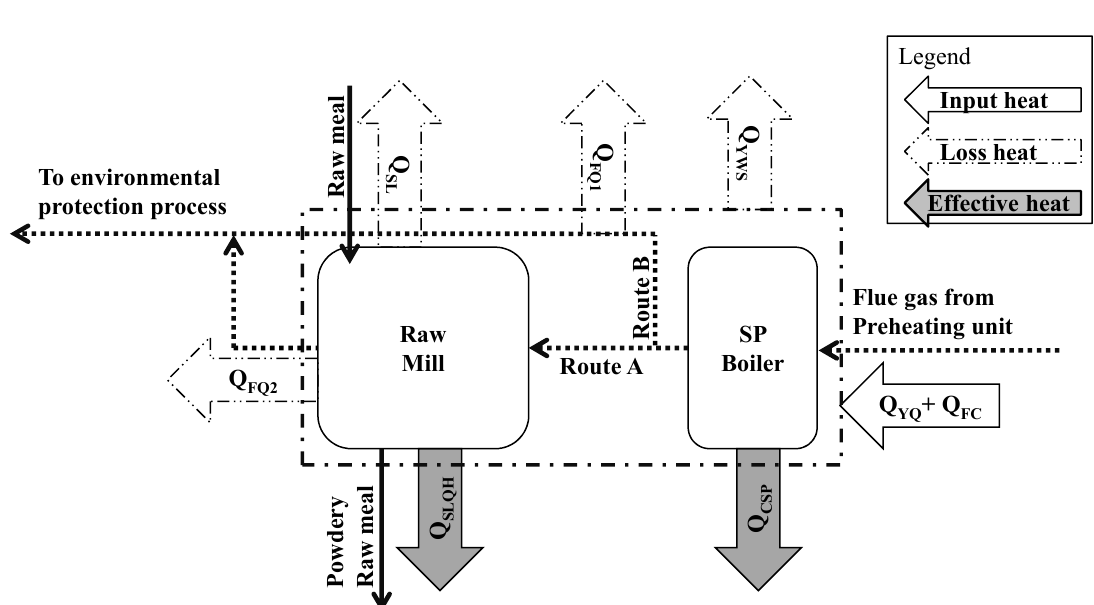
Figure 2. Heat flow modeling of the Raw Material Grinding and SP unit.